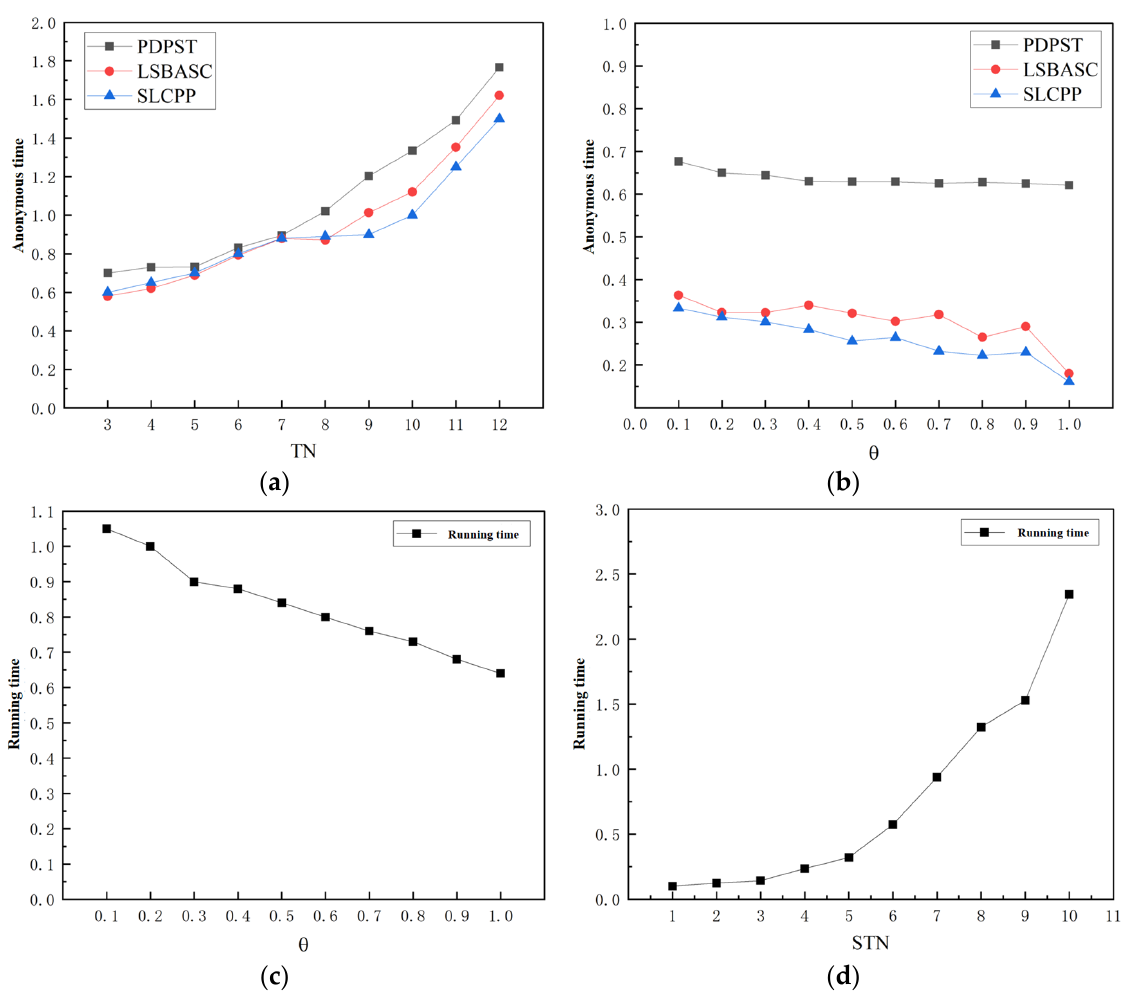
Figure 16. Runtime: ( a ) variation in anonymity time with ( ε = 0.5); ( b ) variation in anonymity time with ( ε = 10); ( c ) variation in running time with ( ε = 5); ( d ) variation in running time with ( ε = 0.5).